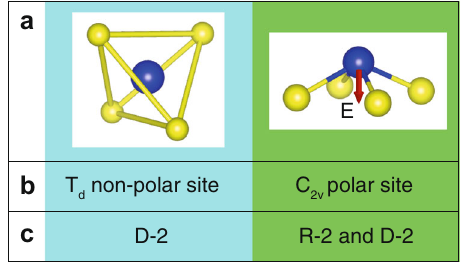
Fig. 1 Classi fi cation of site symmetries leading to local spin polarization. a Examples of non-polar (blue) and polar (green) sites with inversion asymmetry. The red arrow indicates a local dipole moment. b Point groups of the site occupied by the blue atom in a . c Resulting type of spin polarization 8 .